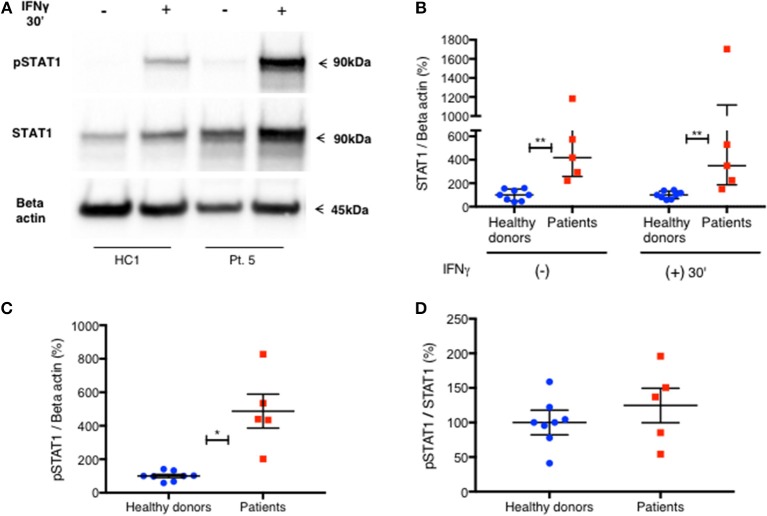
Increased level of PBMC STAT1 protein and pSTAT1 in GOF patients—by immunoblotting. (A) Pt. 5 pSTAT1 and STAT1 protein levels at rest and after 30′ of IFNγ stimulation, compared with a healthy control, as measured by immunoblotting (blots of STAT1 and Beta Actin are from the same gel. pSTAT1 blots are from a duplicate gel of the same samples). (B) STAT1 protein/Beta actin ratio at rest and after 30′ of IFNγ stimulation in five patients (red squares) compared with eight healthy controls (blue dots), as measured by immunoblotting. Data is presented in percentages of the same day healthy controls' average ratio of STAT1/Beta actin, as measured by optical densitometry (OD). (C) pSTAT1/Beta actin ratio after 30′ of IFNγ stimulation in five patients (red squares) compared to eight healthy controls (blue dots), as measured by immunoblotting. Data is presented in percentages of the same day healthy controls' average ratio of pSTAT1/Beta actin, as measured by optical densitometry (OD). (D) pSTAT1/STAT1 protein ratio, 30 min after IFNγ stimulation level in healthy controls (blue dots, n = 8) and GOF patients (red squares, n = 5) as measured by immunoblotting. Data is presented in percentages of the same day healthy controls' pSTAT1/STAT1average ratio as measured by optical densitometry (OD). *P < 0.05; **P < 0.01, by Mann-Whitney (B) or t test (C,D). Quantitative data represent median with interquartile range (B) or mean ± SEM (C,D).